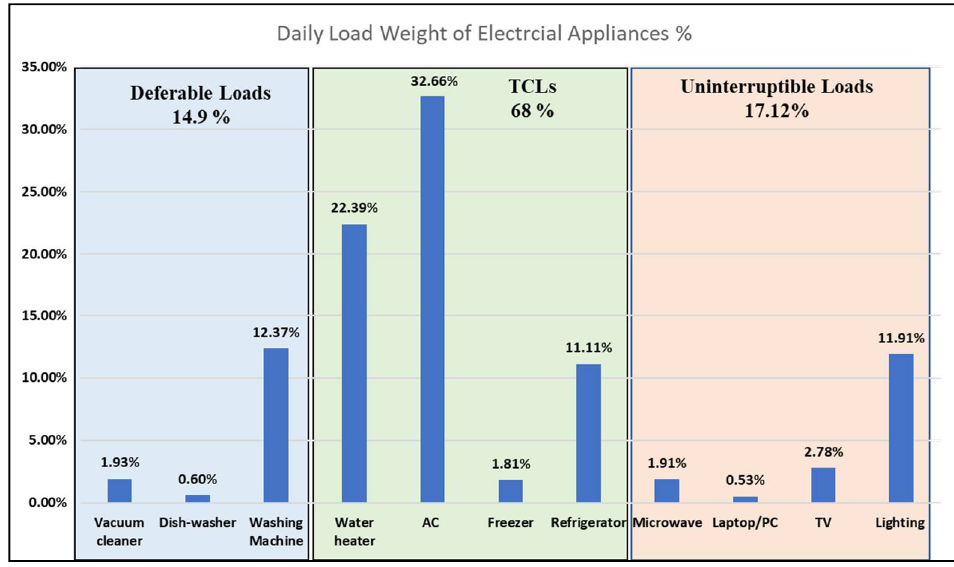
Figure 15. Daily load weights of electrical appliances in Jordan’s residential sector.